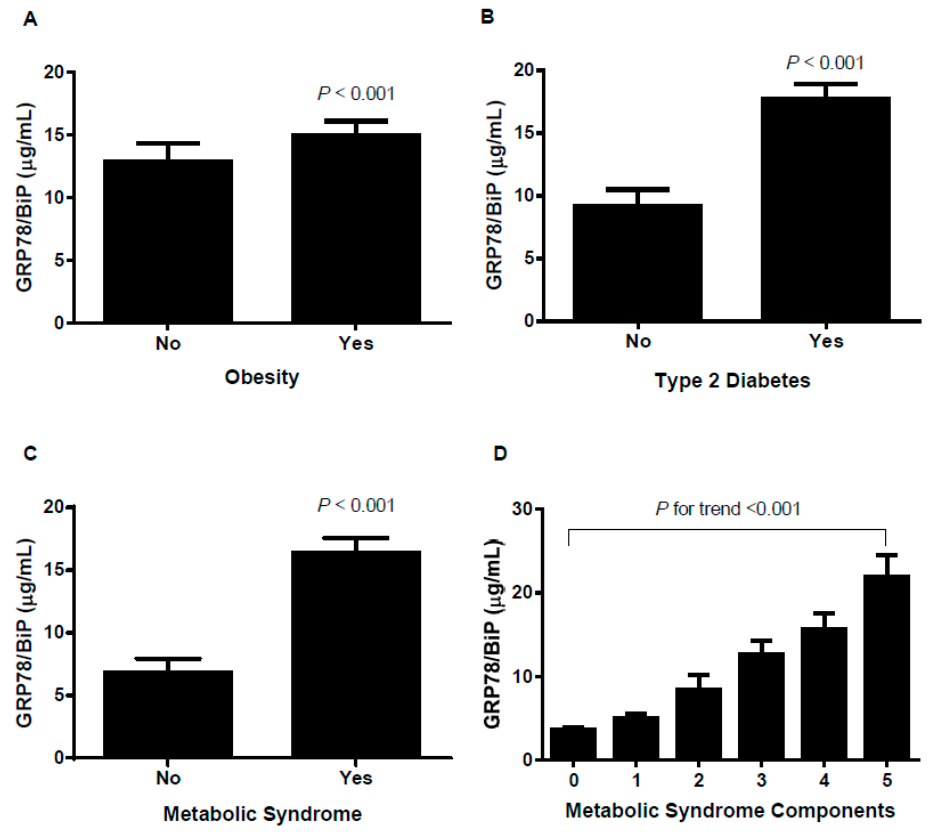
Figure 1. Circulating 78 kDa glucose-regulated protein / binding immunoglobulin protein (GRP78 / BiP) levels according to obesity ( A ), type 2 diabetes ( B ), metabolic syndrome ( C ) and metabolic syndrome components ( D ). The results are expressed as the mean ± SEM. p values for group comparisons are reported for the age- and gender-adjusted ANCOVA test.